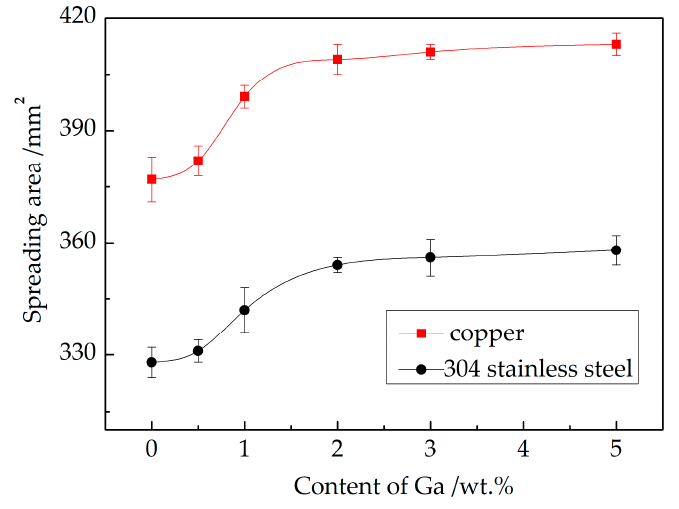
Figure 4. Spreading areas of the novel low-silver filler metals on copper and 304 stainless steel.